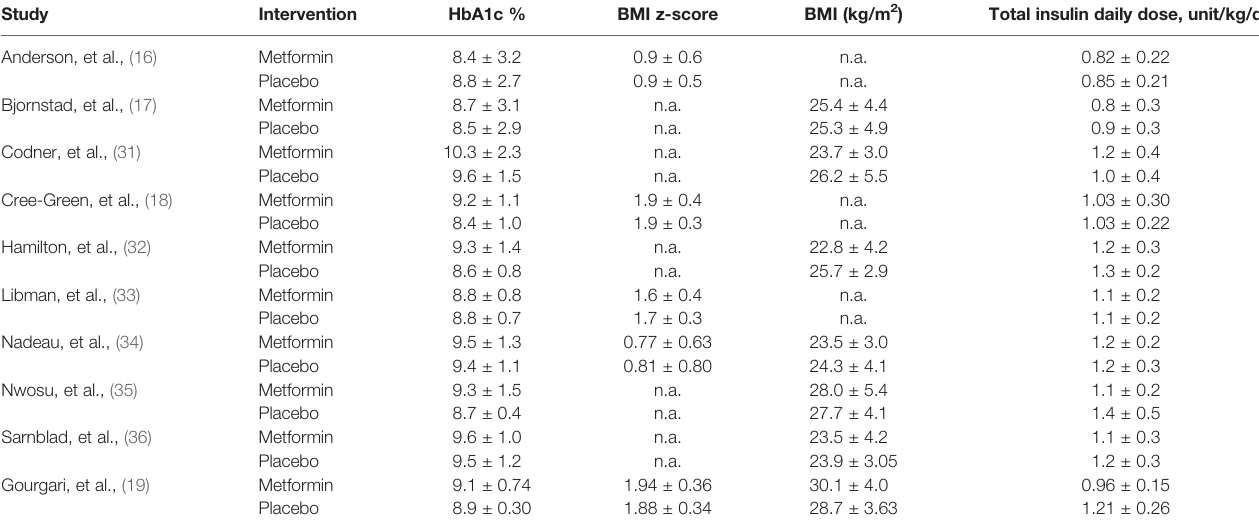
TABLE 2 | Baseline values of endpoints for ef fi cacy. Study